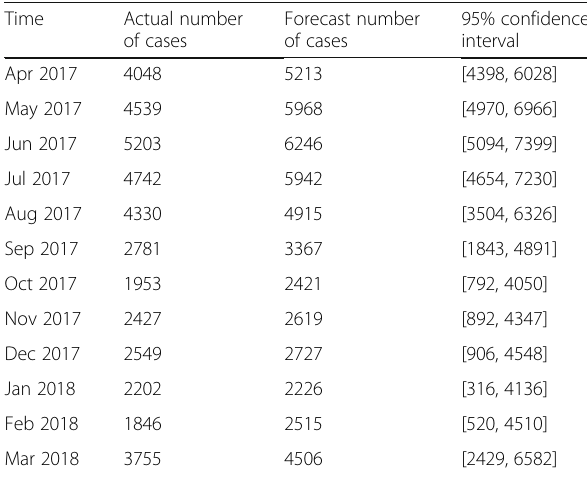
Table 2 Extrapolation prediction of human brucellosis cases in Mainland